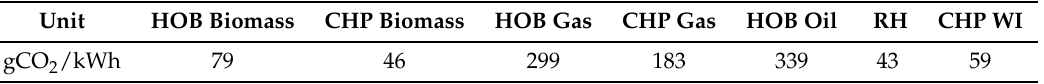
Table A3. Emission factors for district heating units. HOB is the heat only boiler, RH is the waste heat from refineries, and WI is waste incineration.